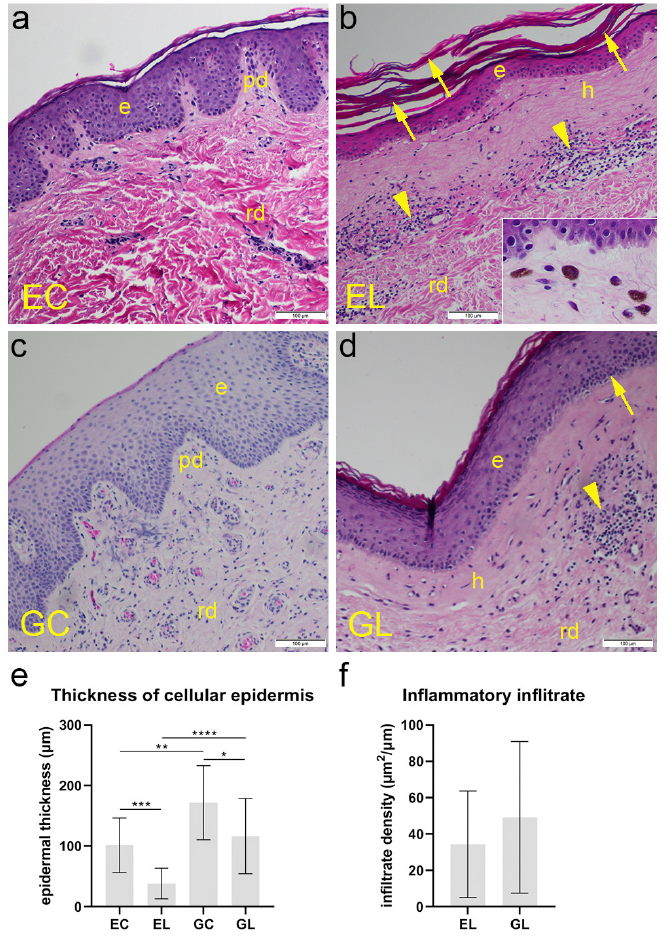
Figure 1. Morphology of normal skin and lichen sclerosus skin samples. EC—normal extragenital skin: typical histologic features of epidermis (e), papillary dermis (pd), and reticular dermis (rd) can be observed ( a ). EL—extragenital skin affected by lichen sclerosus: thinned epidermis (e) with hyperkeratosis (arrows), homogenization and hyalinization of the papillary dermis (h), and lymphocytic infiltrates (arrowheads) in the reticular dermis (rd) can be observed. An accumulation of melanophages is displayed in the inset ( b ). GC—normal vulvar skin: thick epidermis (e) with vascularized papillary (pd) and reticular dermis (rd) can be seen ( c ). GL—vulvar skin affected by lichen sclerosus: homogenization of the papillary dermis (h), a lymphocytic infiltrate (arrowhead) in the reticular dermis (rd), and lymphocyte exocytosis (arrow) in the thinned epidermis (e) can be seen ( d ). Hematoxylin and eosin staining, × 200 magnification; scale bars at the bottom right represent 100 µ m. Analysis of epidermal thickness ( e ); statistical significance was determined by the Kruskal–Wallis test. Analysis of inflammatory infiltrate density measured as the ratio of the area the infiltrate is present in ( µ m 2 ) and the length of the dermal-epidermal junction ( f ); statistical significance was determined by the Mann–Whitney U test. Graphs display mean values with standard deviations shown by error bars. The significance of differences is marked by asterisks: * p < 0.05, ** p < 0.01, *** p < 0.001, **** p < 0.001.